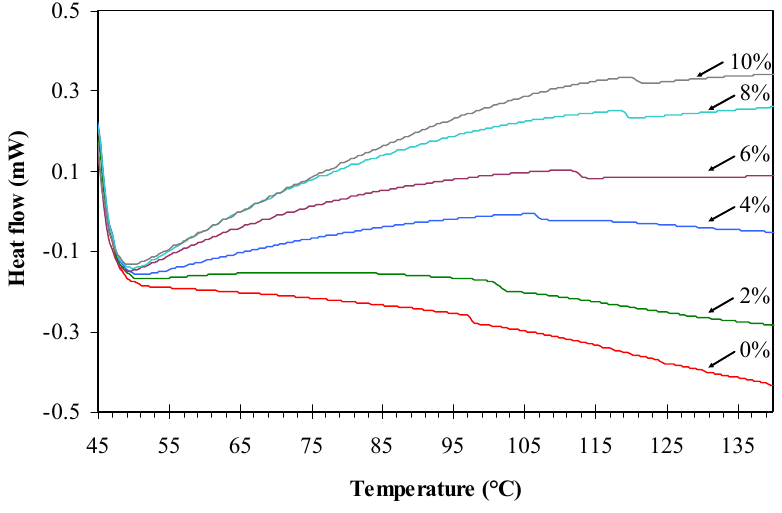
Table 1. Glass transition temperature ( T